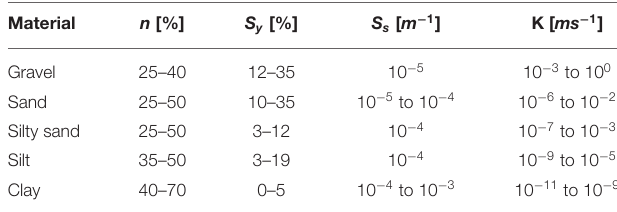
TABLE 1 | Representative values of hydraulic properties for different lithological materials obtained from the literature (Domenico and Mifflin, 1965; Morris and Johnson, 1967; Freeze and Cherry, 1979; Heath, 1983; Domenico and Schwartz, 1990; Batu,